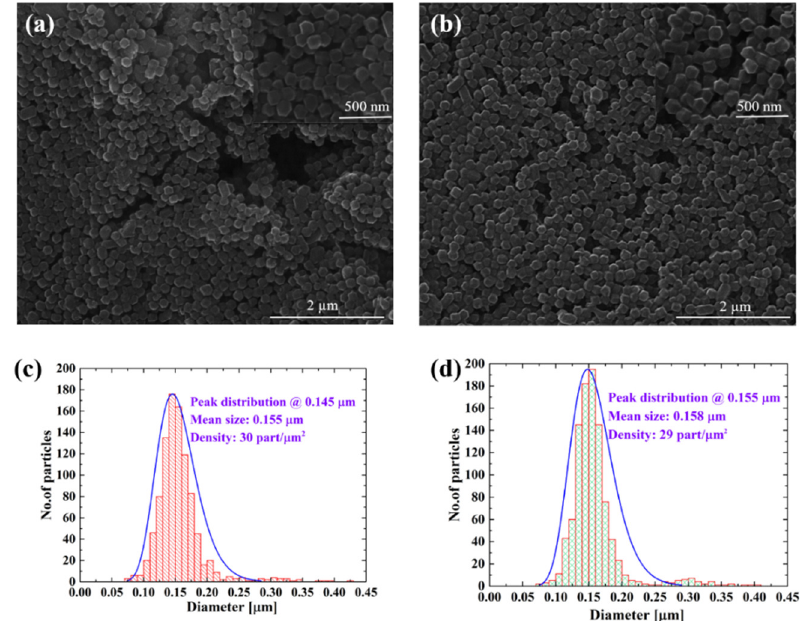
Figure 2. ( a ) SEM image of representative ZIF-8 control with inset showing a higher-resolution analysis of individual ZIF-8 constituents; ( b ) SEM image of representative ZIF-8 film deposited by MAPLE at a 0.45 J · cm − 2 fluence, with inset presenting a higher-resolution analysis of the deposits; ( c ) Histogram of ZIF-8 control with lognormal fit function (blue line); ( d ) Histogram of ZIF-8 thin film deposited via MAPLE using a 0.45 J · cm − 2 fluency with lognormal fit function (blue line).